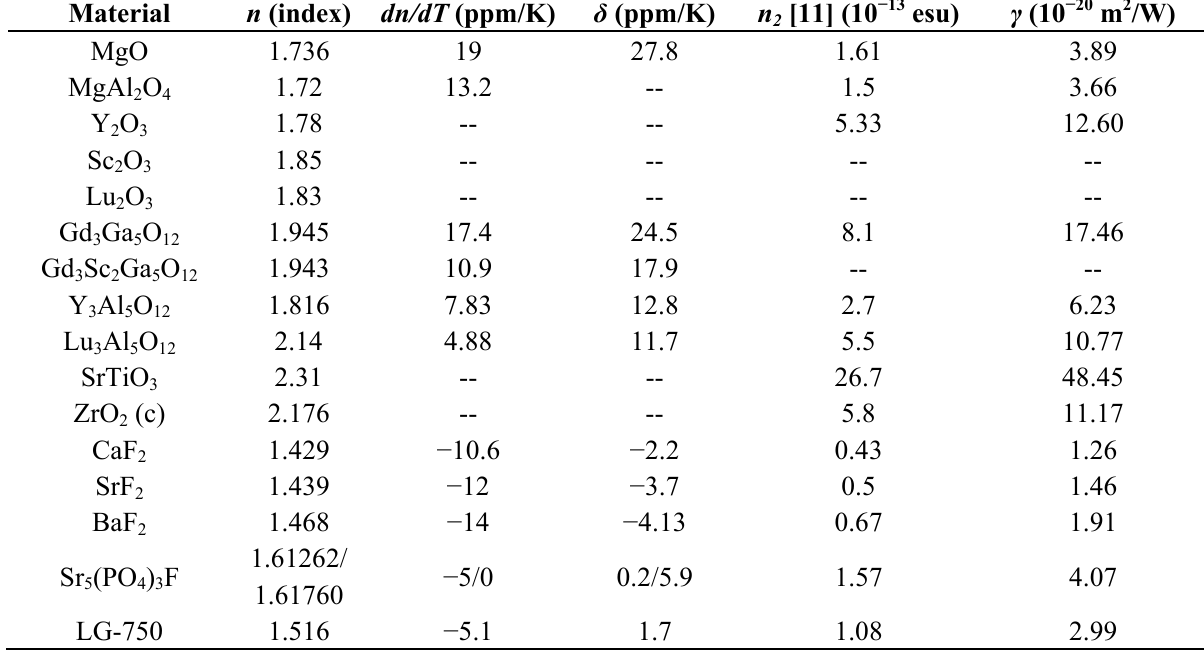
Table 2. Optical properties including the change in index of refraction (d n /d T ) and in optical path length ( δ ) across a slab with temperature and the non-linear coefficient of the , γ ) index of refraction (n 2